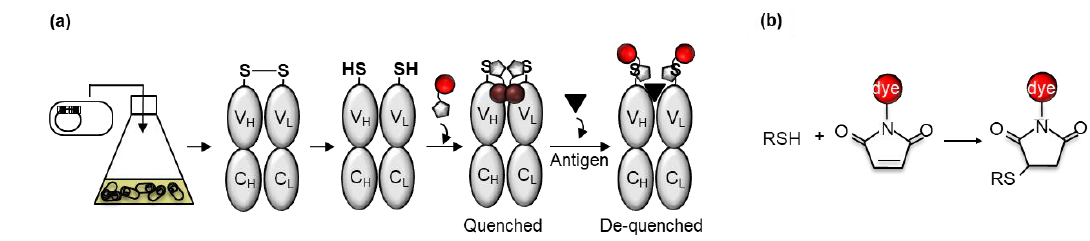
Figure 3. ( a ) Scheme for the construction of Fab type Q-body from Escherichia coli . Q-body with both H- and L-chain labeling sites is represented. Fab is expressed in E. coli cytoplasm and purified by IMAC via His-tag. After mild reduction of the exposed SH group of N-terminal Cys-tag, the dyes are conjugated and unbound dyes are eliminated; ( b ) schematic representation of maleimide-thiol reaction-based conjugating method for labeling a Fab with a fluorescent dye.